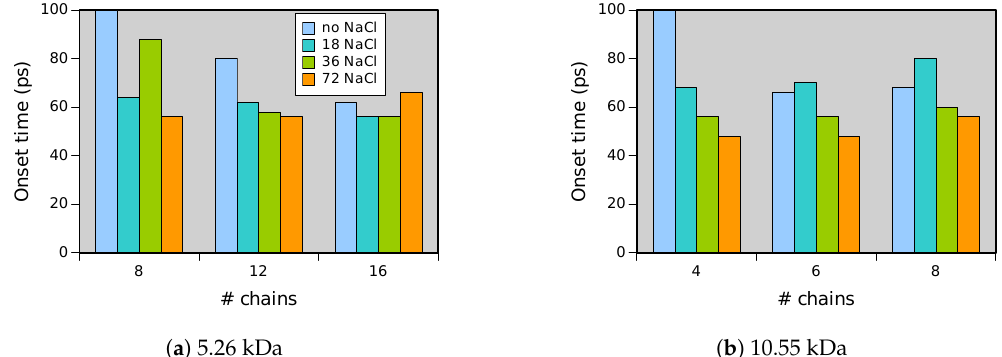
Figure 16. Production times at which the mass transfer of PEG through the plane at z = 20 nm exceeded 500 Da vs. number of chains for different numbers of NaCl ion pairs (see the legend) under 1.5